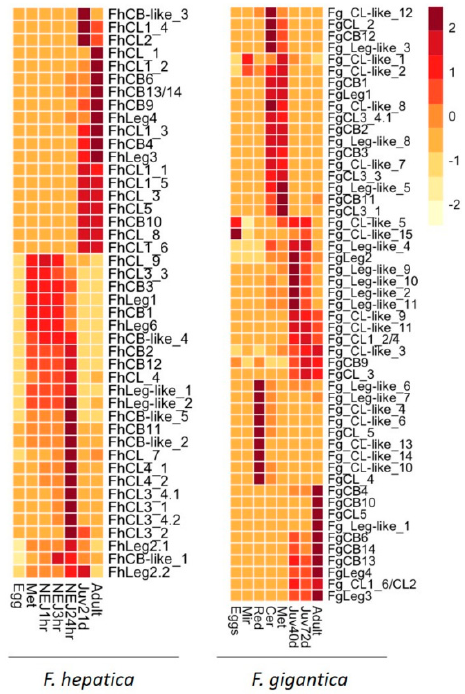
Figure 3. Differential gene expression of the cathepsin L and B peptidase and the legumain genes. Genes expressed by biological replicates of the respective life cycle stages from the F. hepatica and F. gigantica stage-specific transcriptome datasets were grouped by hierarchical clustering, represented by a heatmap generated by pheatmap in R. Up-regulation represented in dark red; down-regulation represented in light yellow. The annotation of the F. hepatica genes is based on the analysis by Cwiklinski et al. [4] and the annotation of the F. gigantica genes is based on the comparative analysis described in this study (detailed in Table S2).